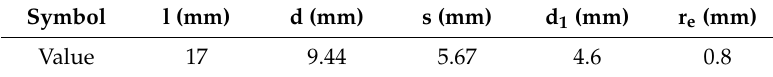
Figure 2. APKT 1604PDR–GM cutting tool. Table 4. Geometric parameters of APKT 1604PDR–GM cutting tool.